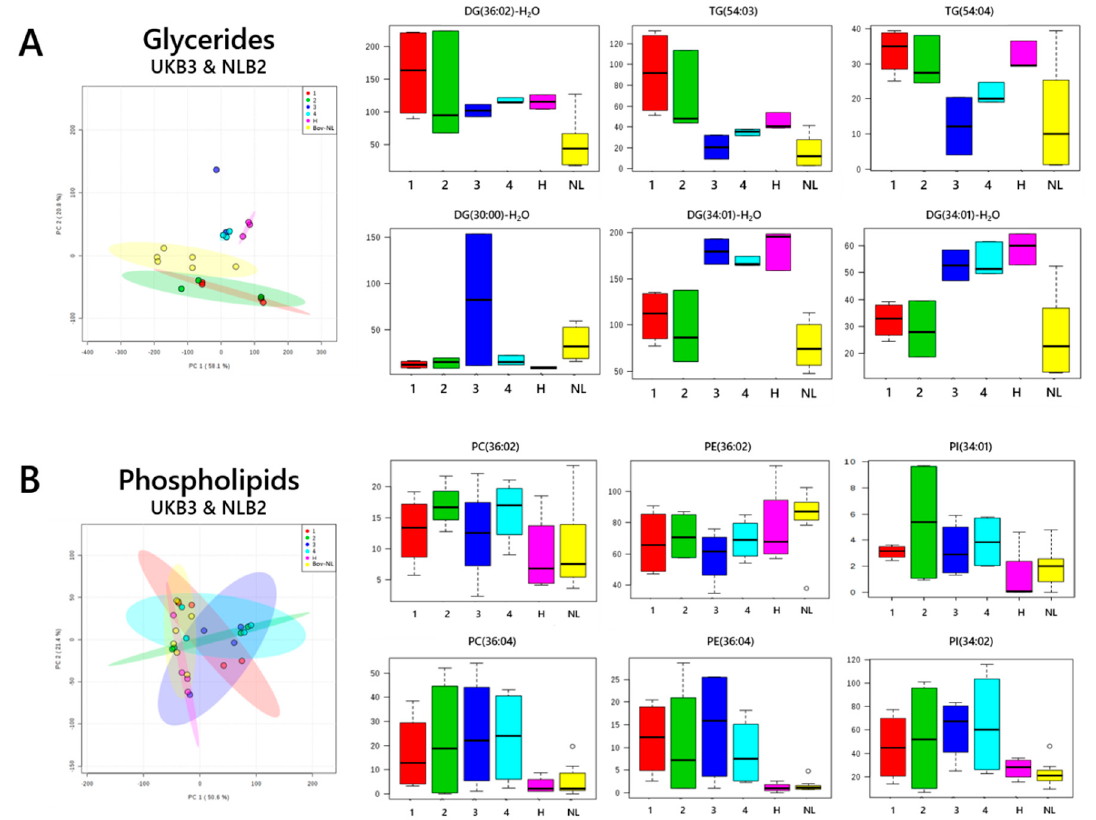
Figure 4. PCAs with important loading variables for Dutch and British brands that are produced by the same manufacturer. Panel ( A ), triglycerides; ( B ), phospholipids. DG, diglycerides; PC, phosphatidylcholine; PE, phosphatidylethanolamine; PI, phosphatidylinositol; TG, triglyceride. 1, 0–6 mo; 2, 6–12 mo; 3, 12–24 mo; 24 mo + ; H, 0–6 mo (hungry); NL, Dutch formula.